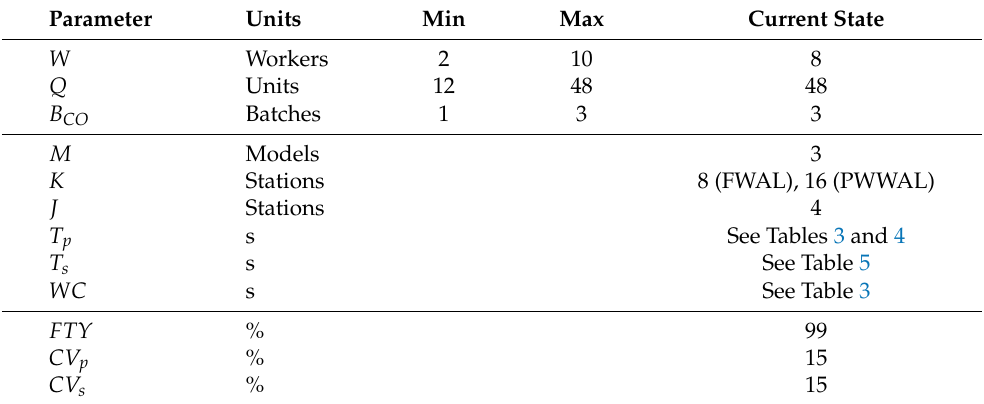
Table 2. Design parameters, fixed parameters, and disturbances considered in the